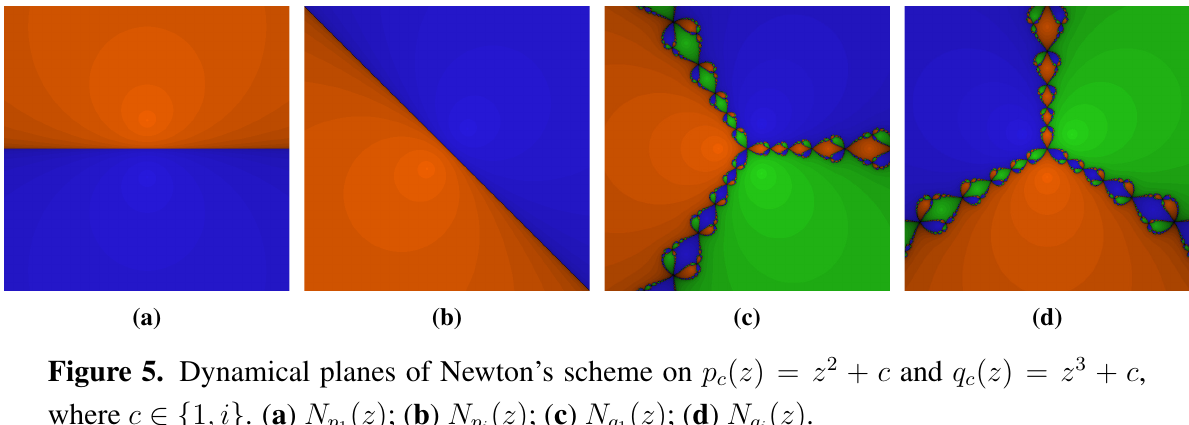
Figure 5. Dynamical planes of Newton’s scheme on p